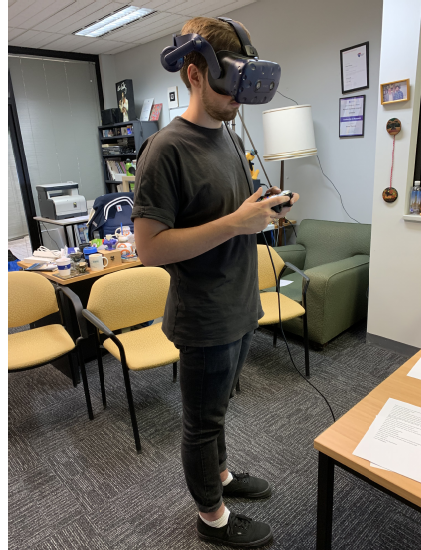
Figure 6. View of the participant using the Logitech